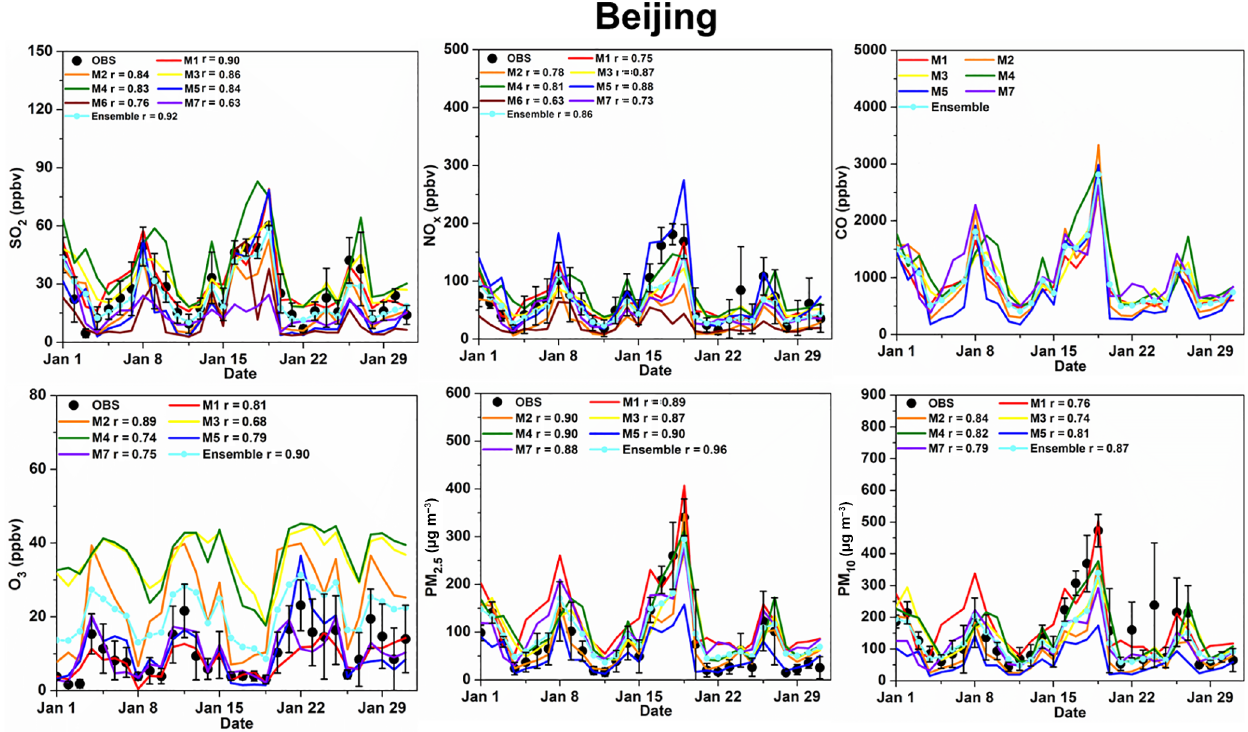
Figure 5. Comparisons between simulated and observed daily air pollutants (SO 2 , NO x , CO, O 3 , PM 2 . 5 and PM 10 ) at the Beijing CARE- China